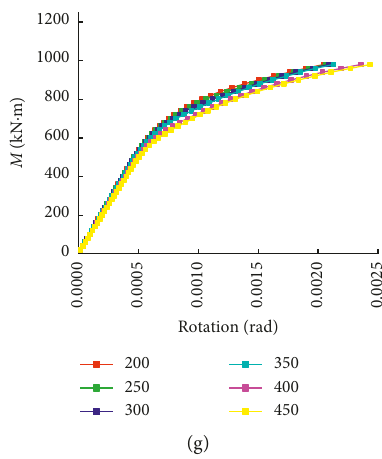
Figure 15: Bending moment-rotation curves for different tenon widths under axial loads of (a) 500kN, (b) 1000kN, (c) 1500kN, (d) 2000kN, (e) 2500kN, (f) 3000kN, and (g) 4000kN.